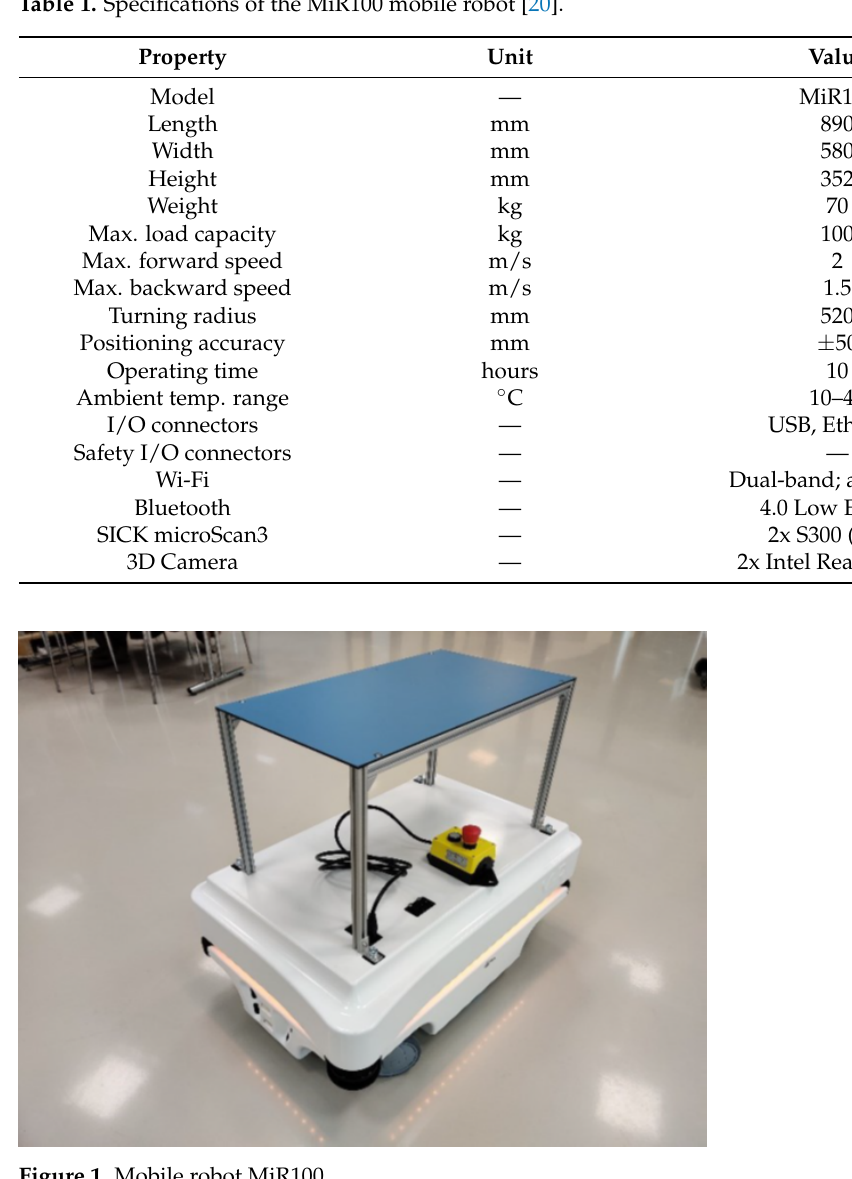
Figure 1. Mobile robot